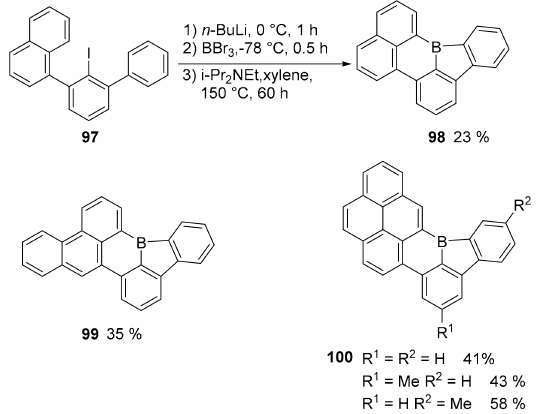
Scheme 25. Synthesis of compound 94 and structures of 95 and 96 .